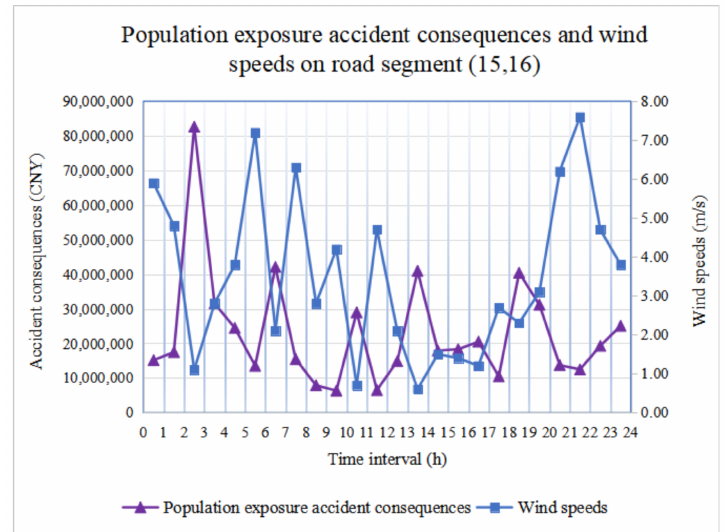
Figure 8. Population exposure accident consequences and wind speed in road segment (15,